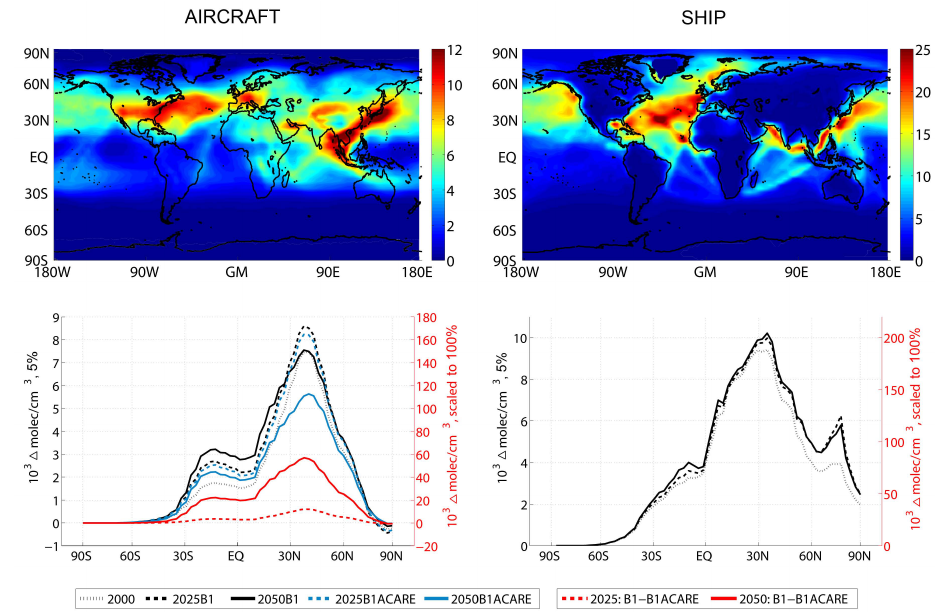
Fig. 10. Mean perturbations of OH (10 3 1 molec cm − 3 ) in July in the upper troposphere (300–200hPa) due to a 5% perturbation of aircraft emissions (left), and in the lower troposphere ( > 800hPa) due to a 5% perturbation of ship emissions (right). The top row figures show results from the 2050 B1 scenario, and the bottom row figures show zonal means for all years and scenarios. The colorbars and the left y-axis show the unscaled impact of the 5% perturbation of the emissions, while the red scales in the bottom figures are scaled up by a factor 20 from 5% to 100% and refer to all lines. The red lines show the difference between the B1 and B1ACARE scenarios and refer to the red axis only. Note that different scales are used for AIR and